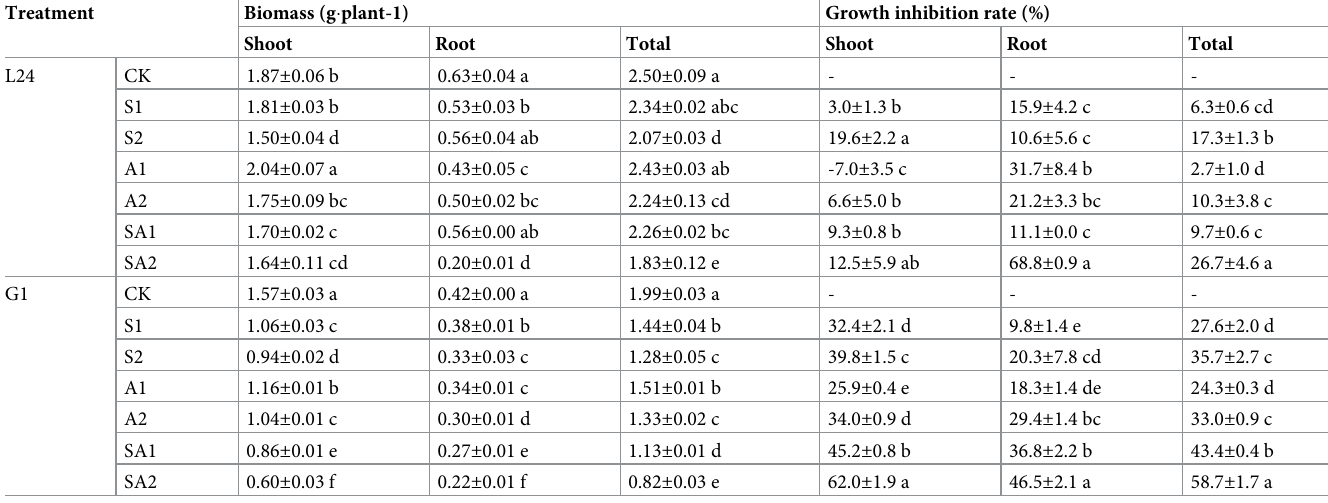
Average data ( ± SE, n = 6) with the different lowercase letters in the same column indicate significant differences ( P < 0.05) among different saline and alkaline stress